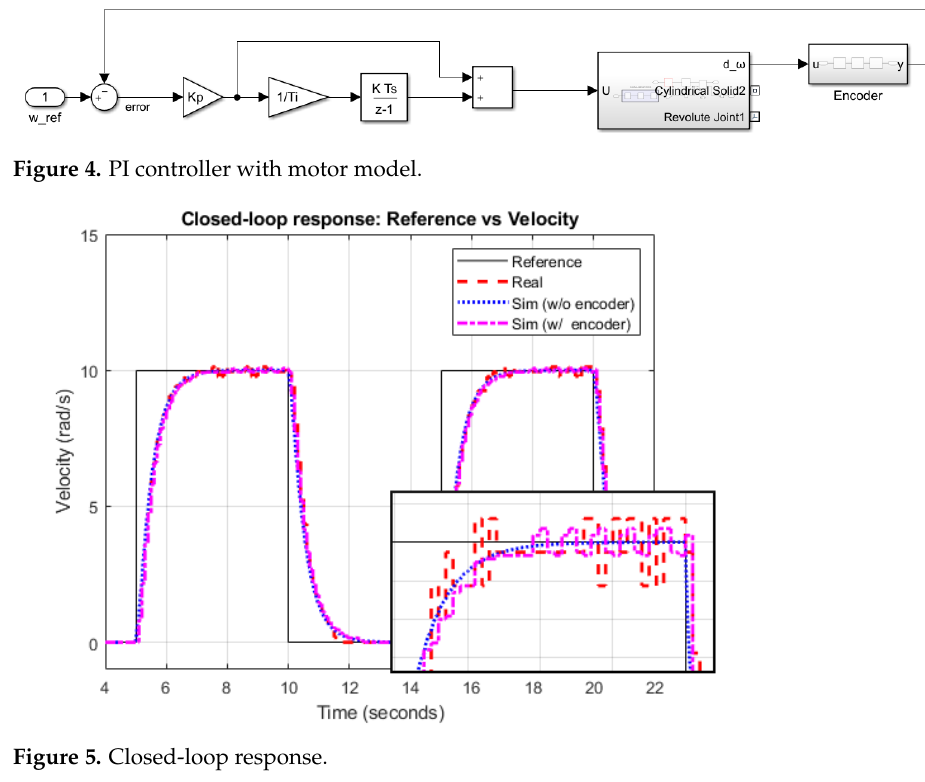
Figure 5. Closed-loop